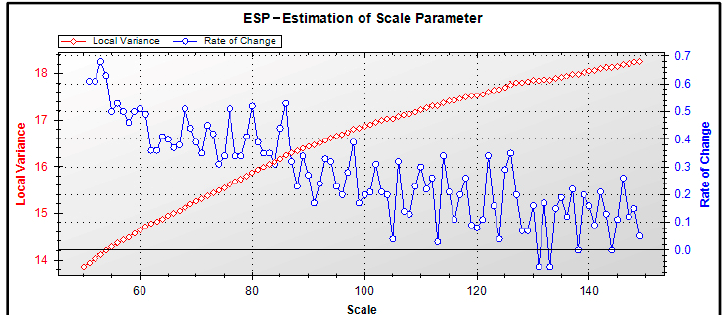
Figure 3. The result of the ESP calculation.